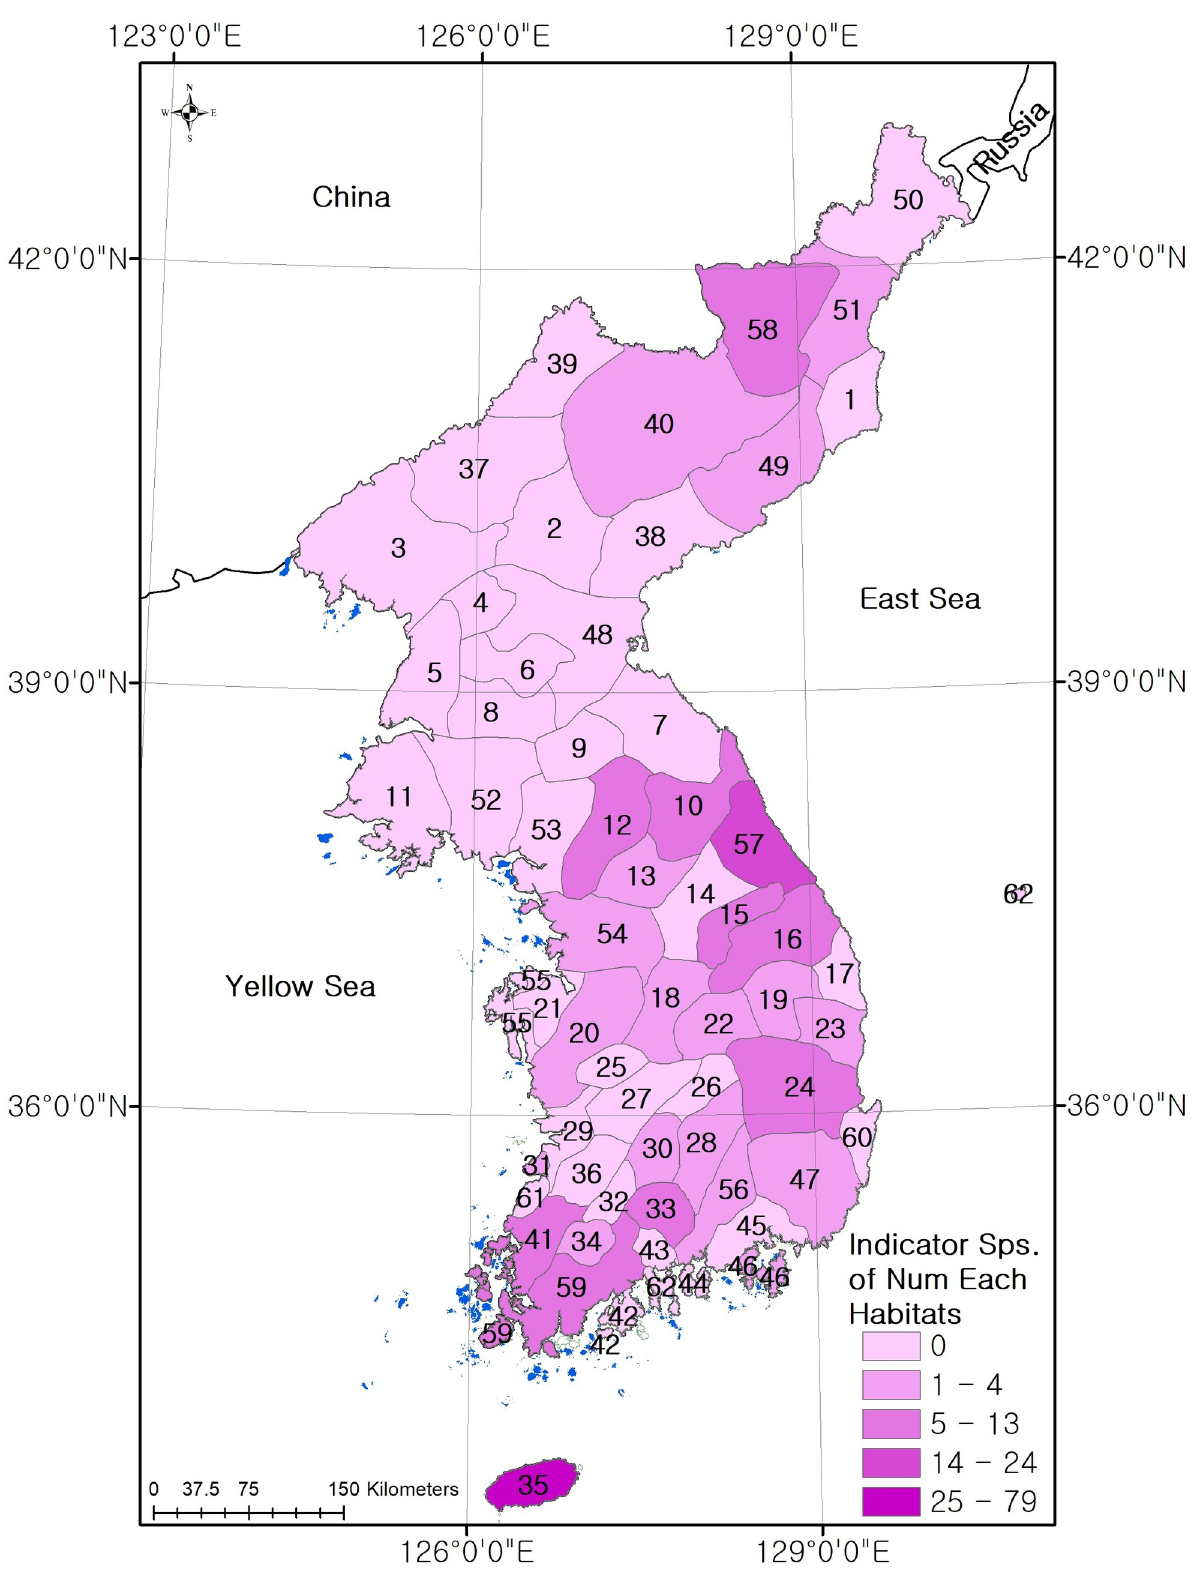
Fig 6. Number of indicator species for each major habitat region in Korean Peninsula (base map data source: Https://gadm.org/).